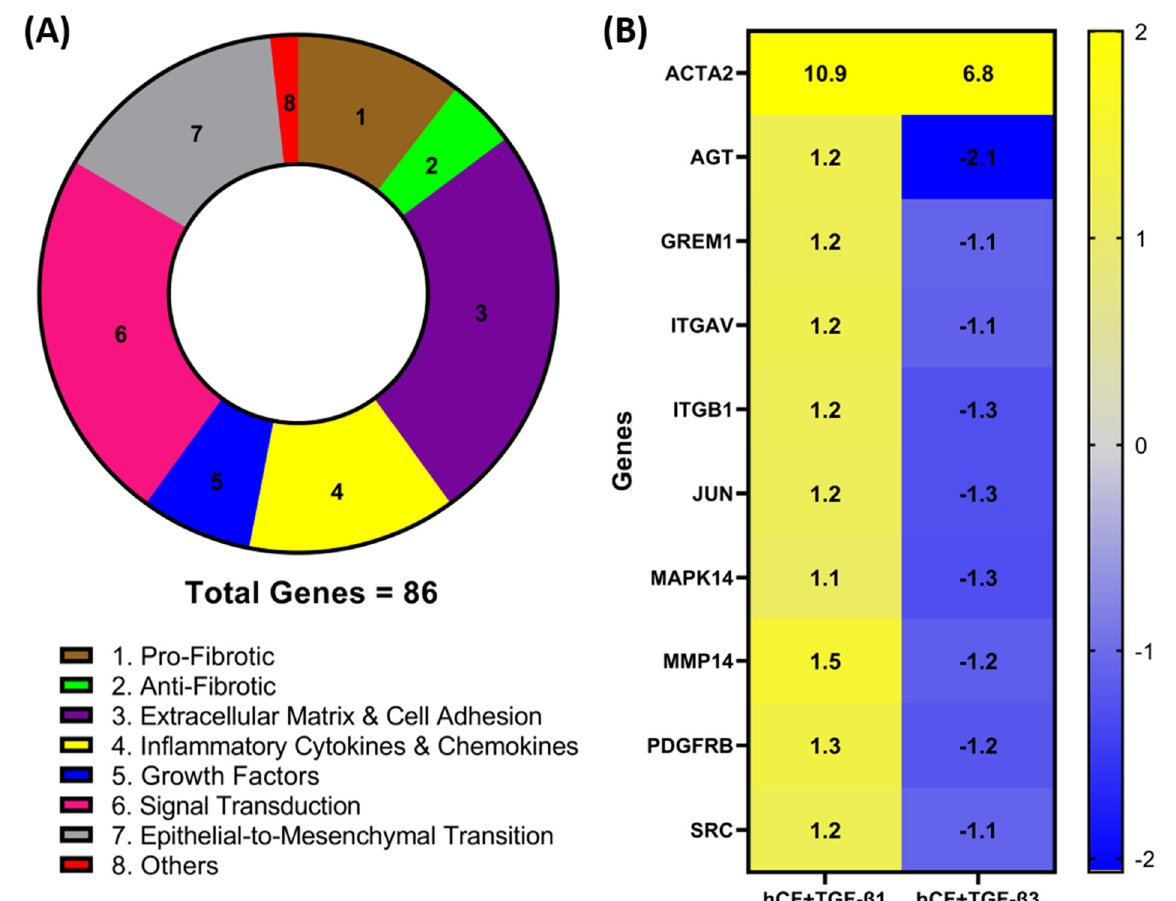
Figure 1. Identification of differentially expressed fibrotic and wound-healing genes following TGF- β 1 or - β 3 treatment in hCF constructs. A RT 2 Profiler PCR array analysis of human fibrosis and wound-healing gene expression was performed. Total RNA was extracted from human corneal fibroblast (hCF) 3D constructs that were untreated or treated continuously with TGF- β 1 or - β 3 for 4 weeks, subjected to cDNA synthesis, and analyzed with Human Fibrosis and Wound Healing PCR Array. ( A ) Pie chart showing distribution of targeted 86 genes and their relevant biological processes (labeled 1–8) within CR array. ( B ) Heatmap of targeted genes comparing RNA profile derived from hCF + TGF- β 1 or hCF + TGF- β 3 relative to untreated hCF constructs with a * p < 0.05: ACTA2, Alpha smooth muscle actin; AGT, Angiotensinogen; GREM1, Gremlin 1; ITGAV, Integrin Subunit Alpha V; ITGB1, Integrin Subunit Beta 1; JUN, Jun Proto-Oncogene, AP-1 Transcription Factor Subunit; MAPK14, Mitogen-Activated Protein Kinase 14; MMP14, Matrix Metallopeptidase 14; PDGFRB, Platelet Derived Growth Factor Receptor Beta; SRC, SRC Proto-Oncogene, Non-Receptor Tyrosine Kinase. Fold change values: blue ( − 2) to yellow (+2) through grey.